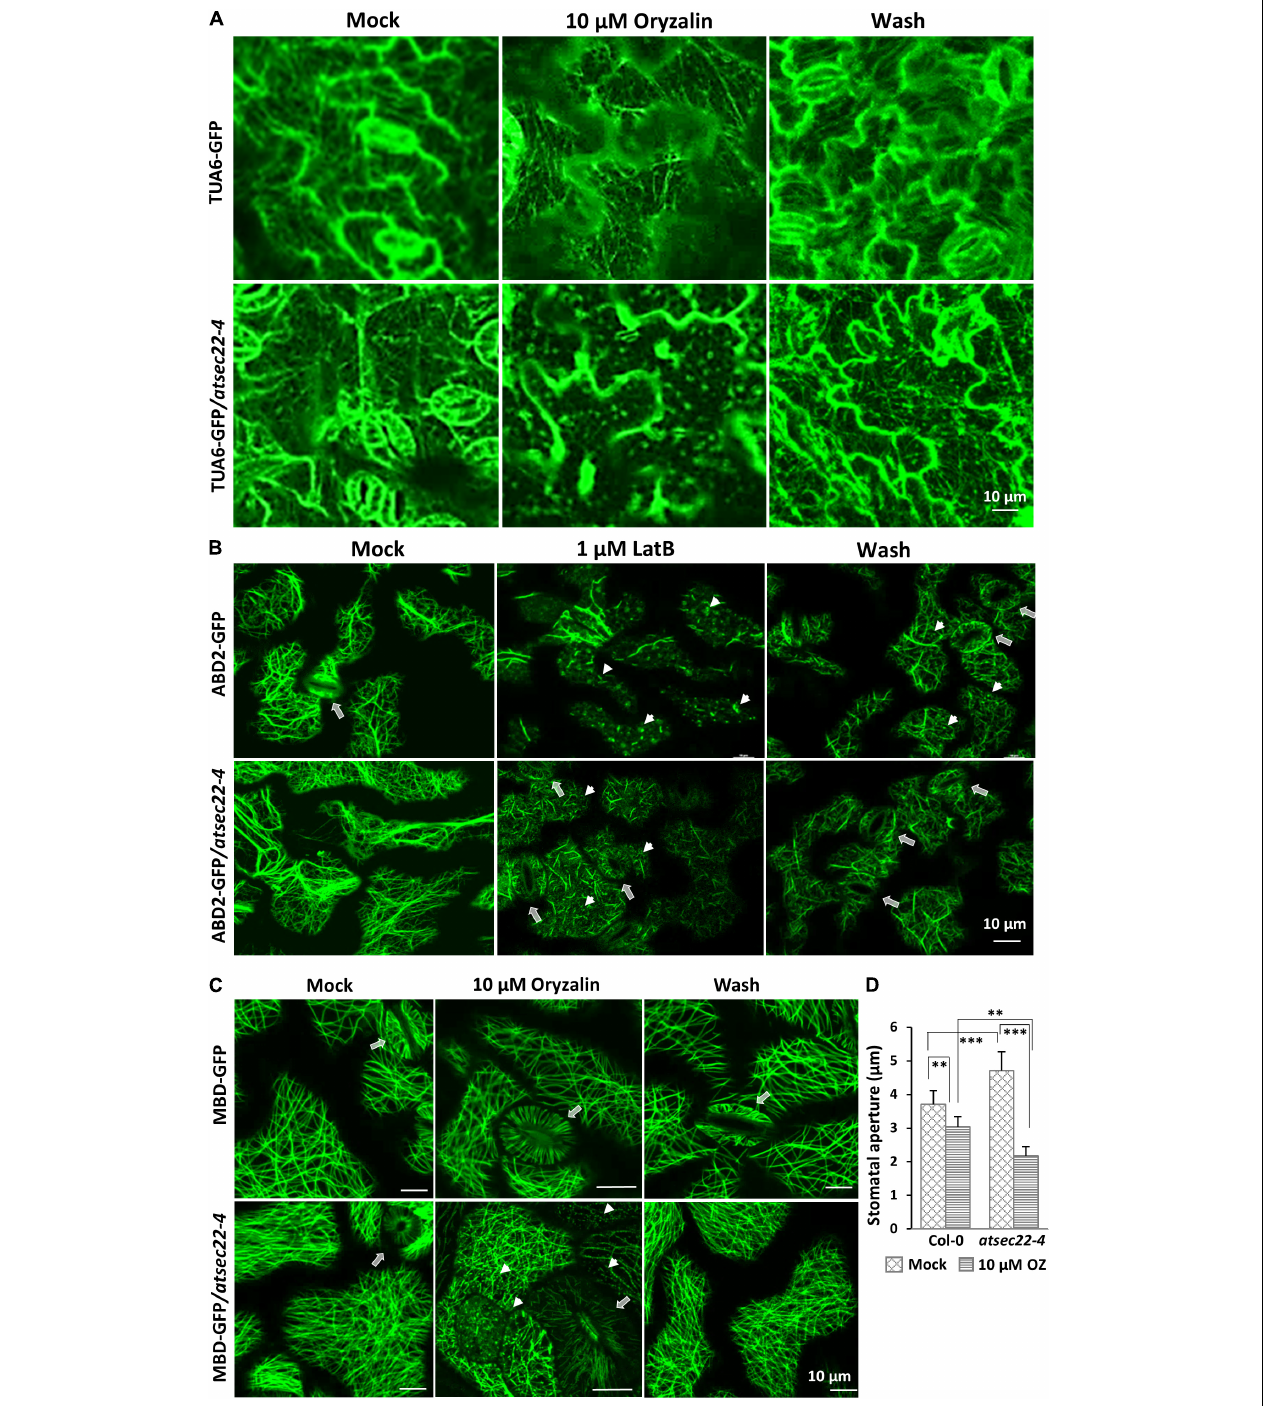
FIGURE 6 | Cytoskeleton stability was perturbed in atsec22-4. (A) Cortical MTs in atsec22-4 were sensitive to oryzalin treatment. TUA6-GFP-visualized cortical MTs in leaves from 12-day-old seedlings were treated with 10 µ M of oryzalin for 20 min, and followed by a 2 h wash. (B) Cortical AFs in atsec22-4 were resistant to LatB treatment. ABD2-GFP-visualized cortical AFs in leaves from 12-day-old seedlings were treated with 1 µ M of LatB for 20 min, and followed by a 2 h wash. Arrows, stomata; arrow heads, depolymerized AFs. (C) Stomata movement was abnormal in atsec22-4 . MBD-labeled cortical MTs in leaves from 12-day-old seedlings were treated with 10 µ M of oryzalin for 20 min, and followed by a 2 h wash. Arrows, stomata; arrow heads, depolymerized MTs. (D) Statistics of stomata aperture in panel (C) . n ≥ 30. Scale bars are as shown. ** P < 0.01, *** P < 0.001. Significance was evaluated by Student’s t test.